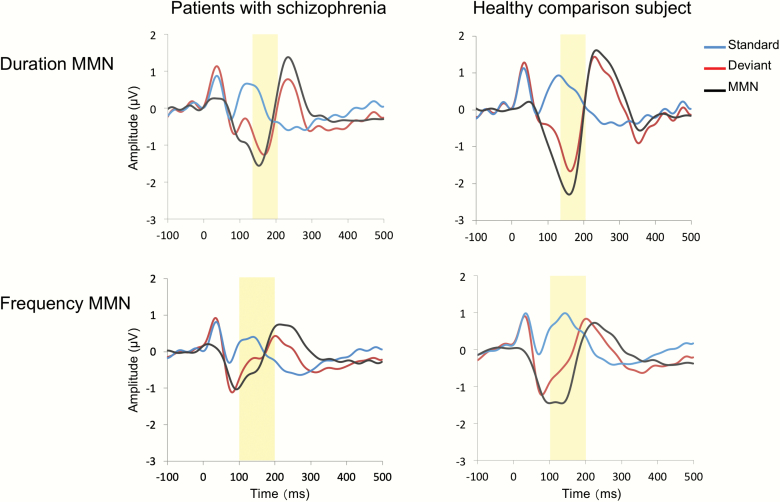
The average waveforms of mismatch negativity (MMN) at the FCz in patients with schizophrenia and healthy comparison subjects. The amplitude of the duration MMN was measured as the mean voltage from 135 to 205 ms post-stimulus, and the amplitude of the frequency MMN was measured as the mean voltage from 100 to 200 ms (shaded yellow) (Colored figure is available online).